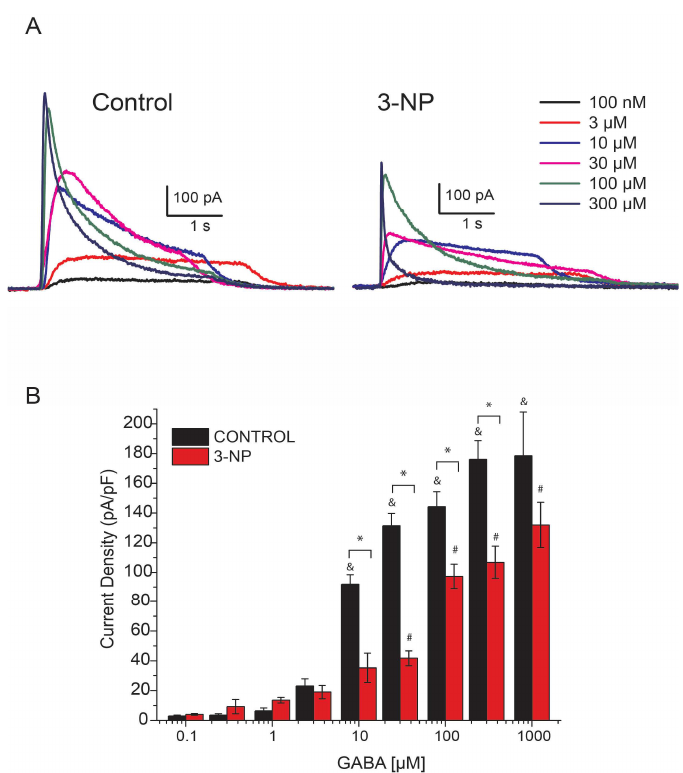
Figure 2. Dose-dependent response of GABA-activated current. ( A ) Representative traces of the activated current for 0.1, 3, 10, 30, 100, and 300 µ M GABA from the MSNs of control and 3-NP mice. ( B ) Concentration dependent response to GABA is expressed as current density. The response to 10, 30, 100, and 300 µ M of GABA was statistically different between control and 3-NP groups (F 1, 94 = 6.39, p < 0.01, two way ANOVA), the GABA induced current amplitude increased significantly in both groups by rising the concentration of GABA from 10 µ M for control group and from 30 µ M for 3-NP groups (F 8, 94 = 26.02, p < 0.05, two way ANOVA). Significant differences among GABA concentration are indicated with ( & ) for control group and with ( # ) for 3-NP groups and with a (*) for differences between 3-NP and control groups. Control group (black), 3-NP group (red). &, #, * p < 0.05